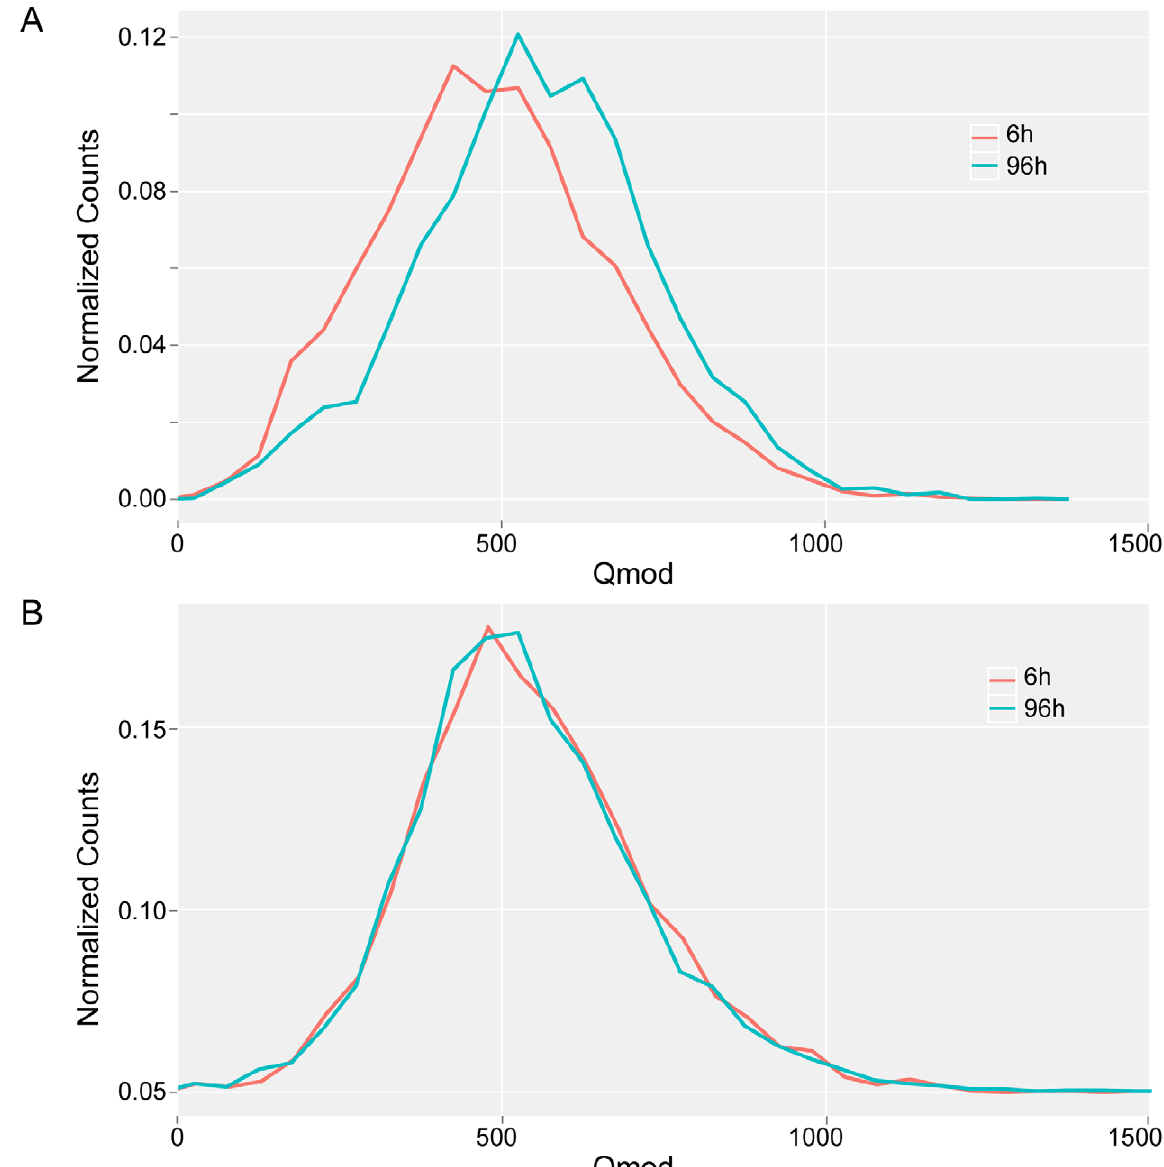
Figure 6. Qmod distributions. Qmod distributions of 5 9 -CT A T-3 9 ( A ) and 5 9 -G A N 7 TAY-3 9 /3 9 -CTN 7 A TR-5 9 motifs ( B ) for M. pneumoniae genome at exponential (6 h, red line) and stationary (96 h, blue line) phases of